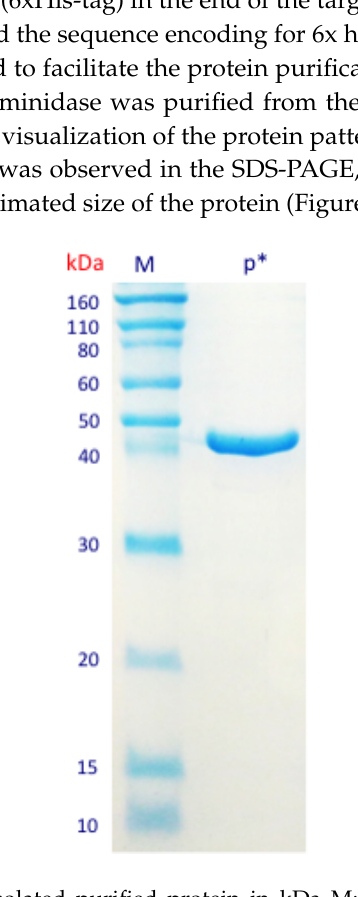
Figure 2. SDS-PAGE of the isolated purified protein in kDa M: Molecular marker; p* Purified protein band.